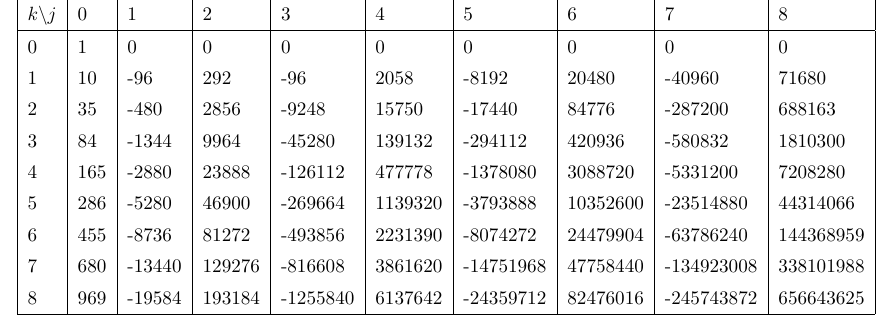
Table 34. Table of b jk coe(cid:14)cients for h Sp(2)